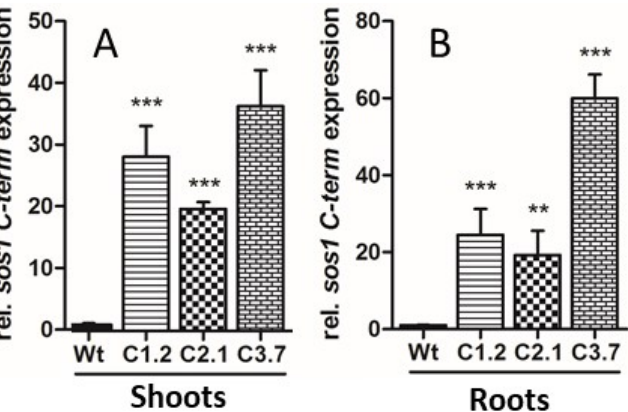
Figure 4. Relative overexpression levels of SOS1-C-terminus in Arabidopsis shoot and root tissue, revealed by quantitative RT-PCR. ( A ) Relative overexpression of SOS1-C-terminus in shoots, ( B ) relative overexpression of SOS1-C-terminus in roots. Arabidopsis plants were grown in hydroponic culture for five weeks, prior to watering for three days with 150 mM NaCl. Data represent means of six independent biological replicates. Data normalized to the housekeeping gene pp2a ( At1g13320 ). Error bars are ± SE. Data with *** are significant from Wt at p < 0.001, data with ** are significant from Wt at p < 0.01 (two-way ANOVA).